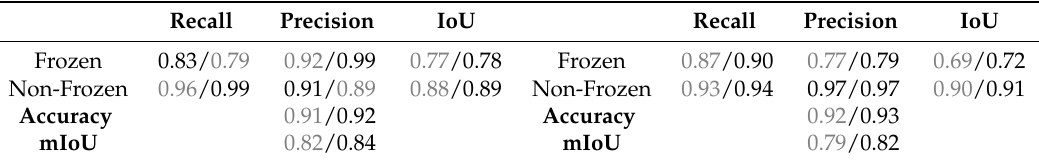
Table 12. VIIRS leave one winter out results. The numbers are shown in A/B format where A and B represent the outcomes using RBF and linear kernels respectively. The better kernel for a given experiment is shown in black, worse kernel in grey. Left is winter 16–17, right is winter 17–18. Recall Precision IoU Recall